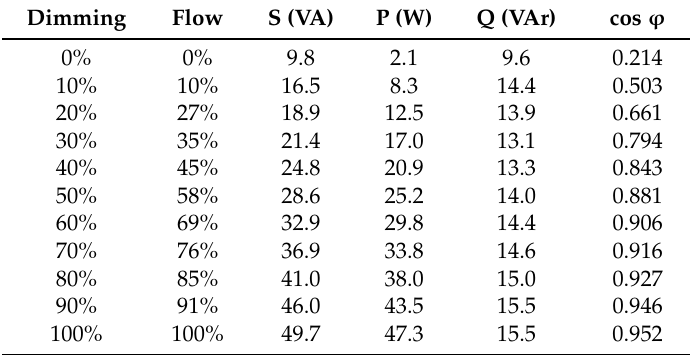
Table 1. Consumption and illuminance values at three checkpoints after programming. Dimming